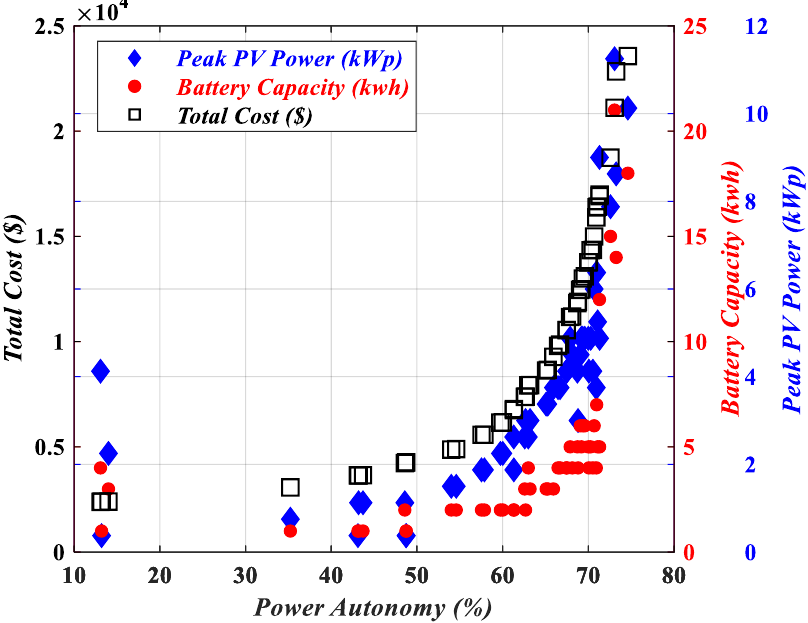
Figure 6. Total cost and power autonomy factor for a variety of PV panel installation areas and battery capacity values for Malaga (commercial area).